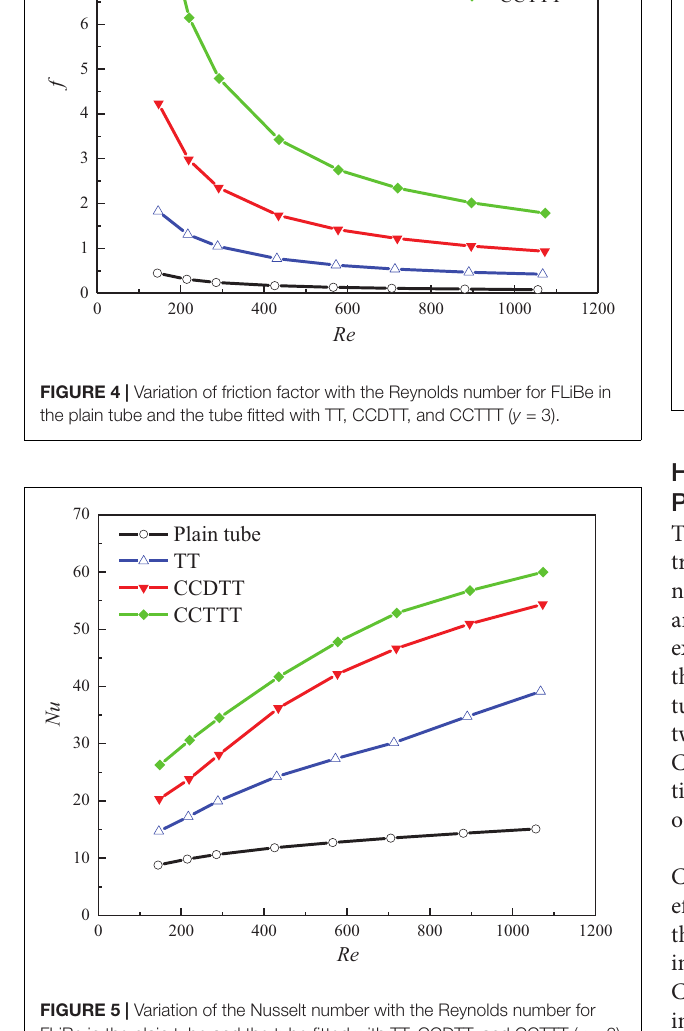
FIGURE 5 | Variation of the Nusselt number with the Reynolds number for FLiBe in the plain tube and the tube fitted with TT, CCDTT, and CCTTT ( y = 3).